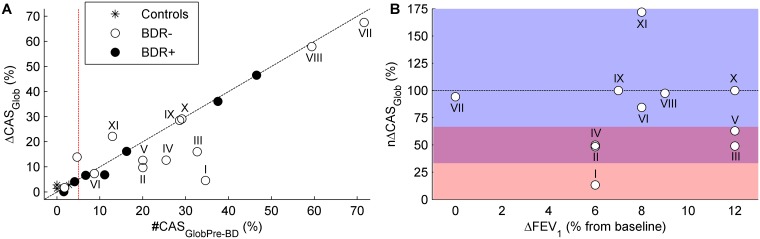
Individual change in the number of CAS after bronchodilator administration.A) Number of CAS at baseline (#CASGlobPre-BD) and change in the number of CAS (ΔCASGlob) of each study subject. The dashed line is the line of equality (ΔCASGlob = #CASGlobPre-BD). That is, points on the line corresponded to subjects whose CAS completely disappeared after bronchodilation. Points under the line corresponded to subjects whose number of CAS was partially reduced after bronchodilation. Points above the line corresponded to subjects whose number of CAS increased after bronchodilation. B) ΔFEV1 and nΔCASGlob of BDR- patients whose #CASGlobPre-BD was >5% (white points to the right of the red dashed line in A). Points in A and B corresponding to the same subject have been labelled with the same Roman numeral. As in A, the dashed line in B represents ΔCASGlob = #CASGlobPre-BD, which means nΔCASGlob = 100% (see Eq 6). Pink area: 0%<nΔCASGlob<33%, purple area: 33%<nΔCASGlob<66%, blue area: 66%<nΔCASGlob.